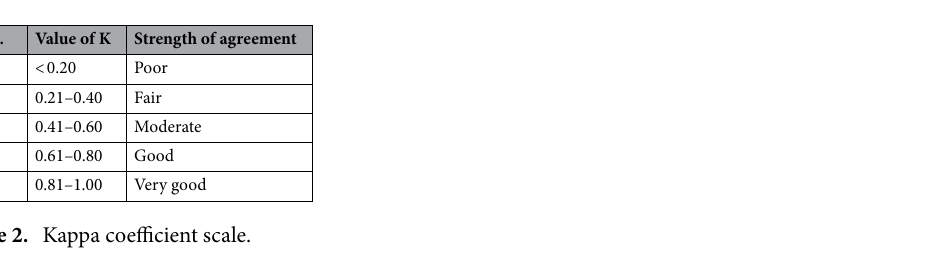
Figure 2. The adopted methodological framework of the current study.